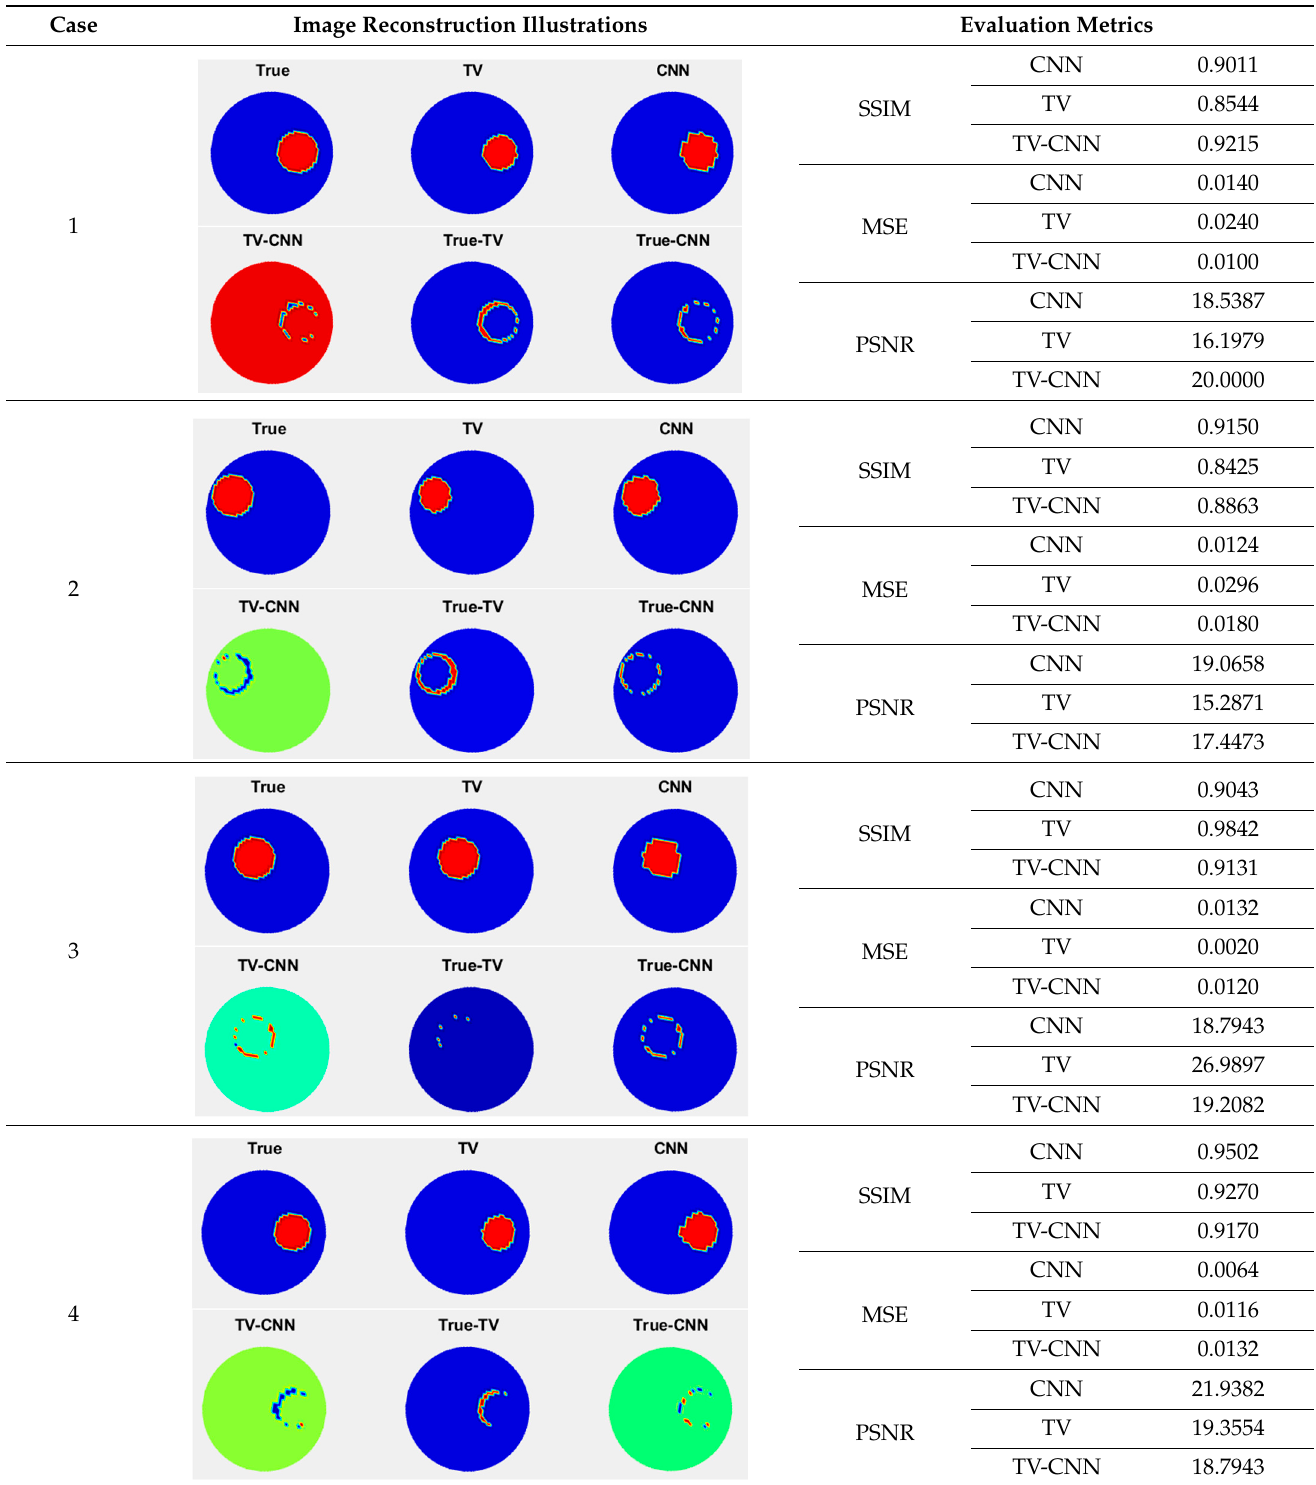
Table 4. Detailed simulation reconstruction results and accuracy analyses.